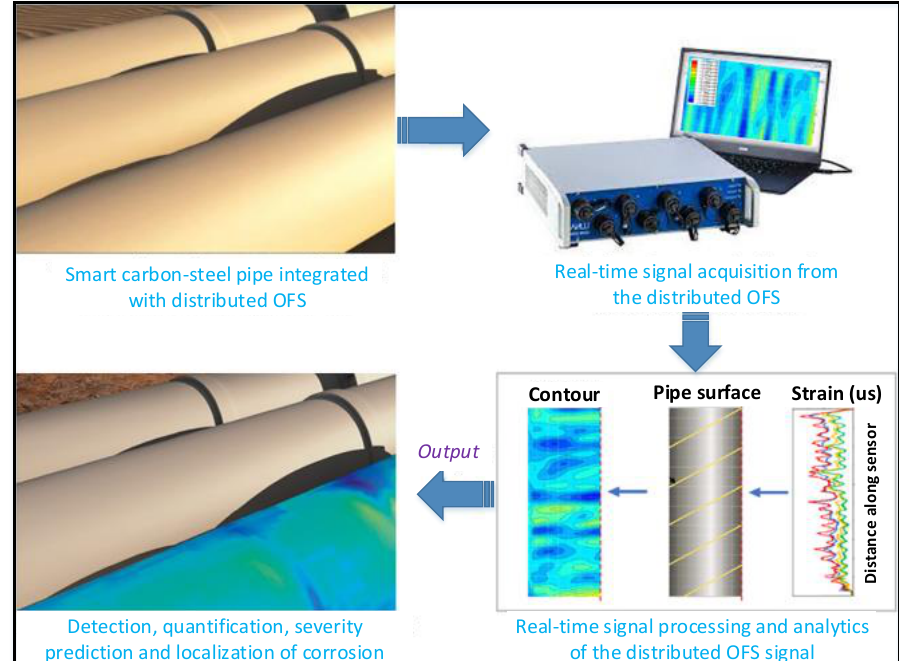
Figure 6. Schematic for distributed OFS based corrosion monitoring method [63].